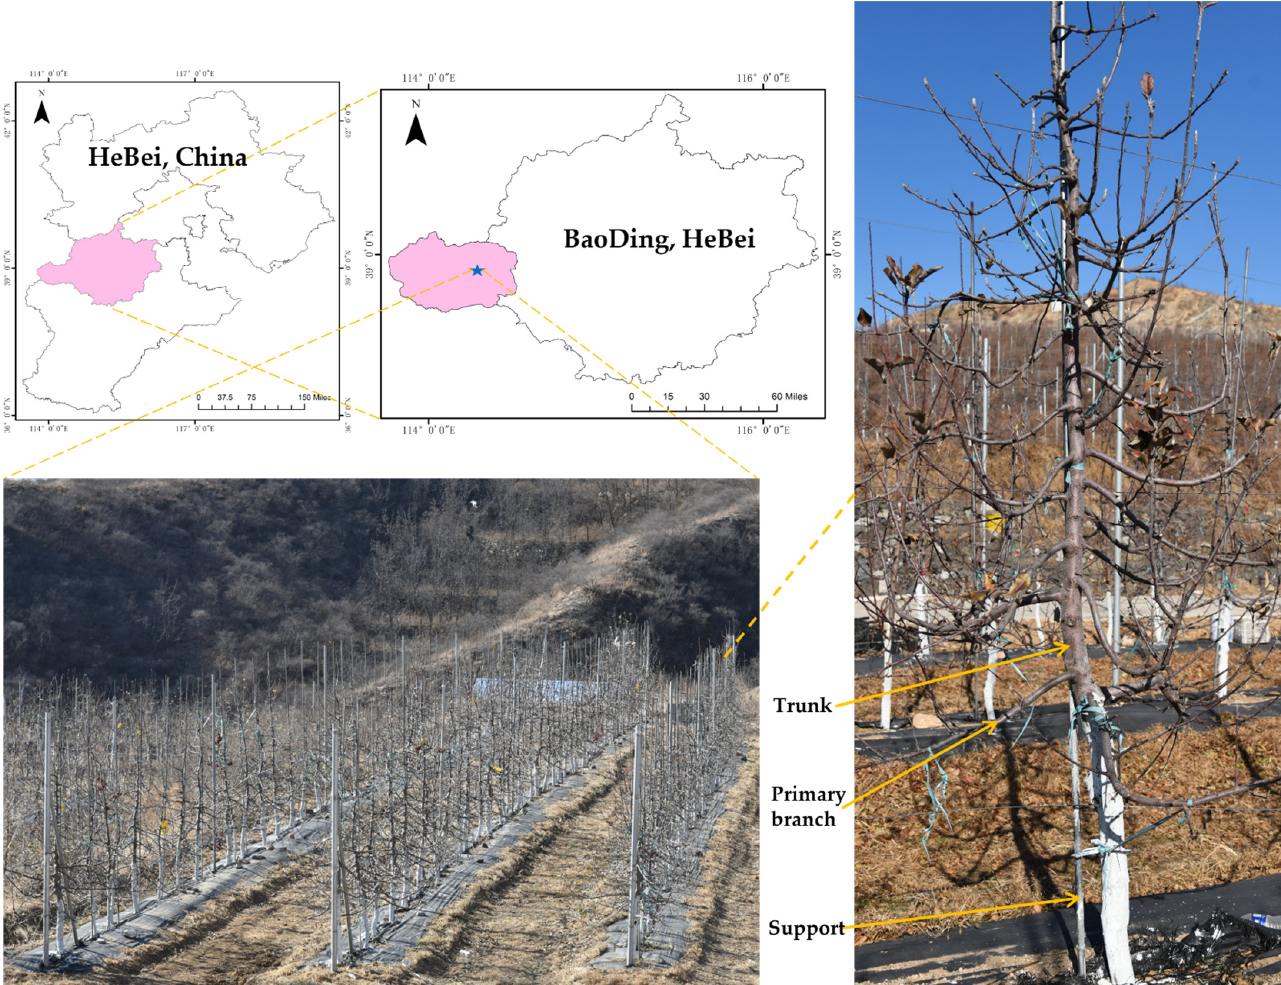
Figure 1. Orchard and apple trees on the experimental